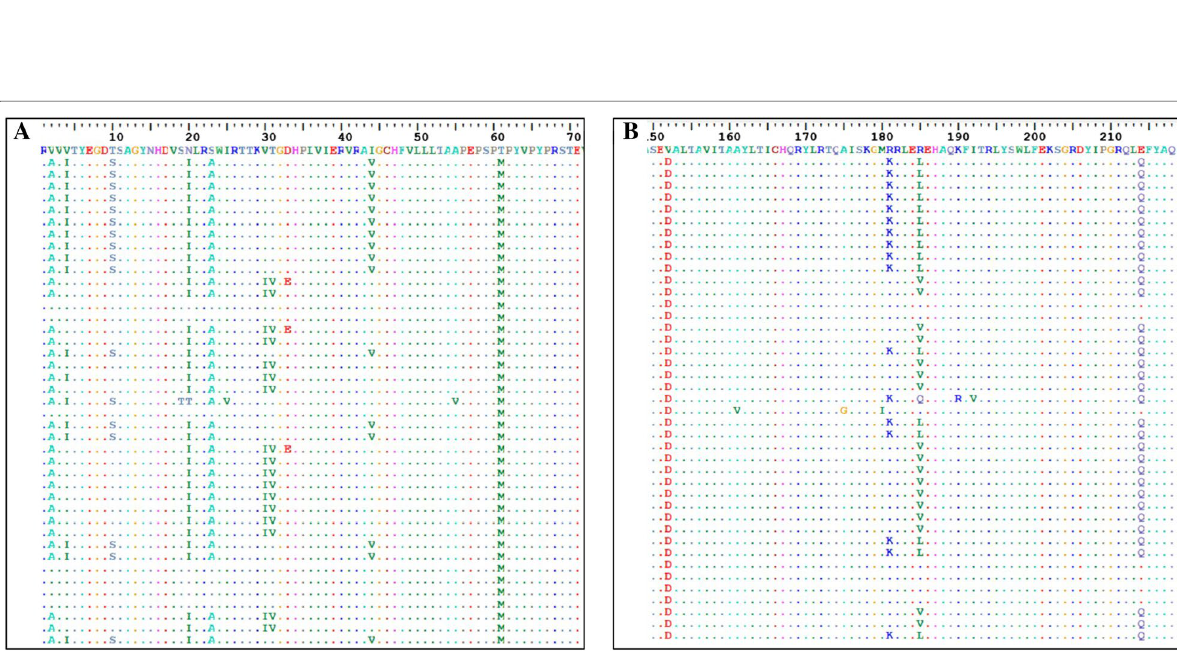
Fig. 3 Alignment showing the comparative analysis of amino acid sequences in Y-domain protein genes of HEV genomes at ( A ) N-terminal and ( B ) C-terminal. The substitutions are shown by amino acid symbols at the respective positions, and similarities are represented by the